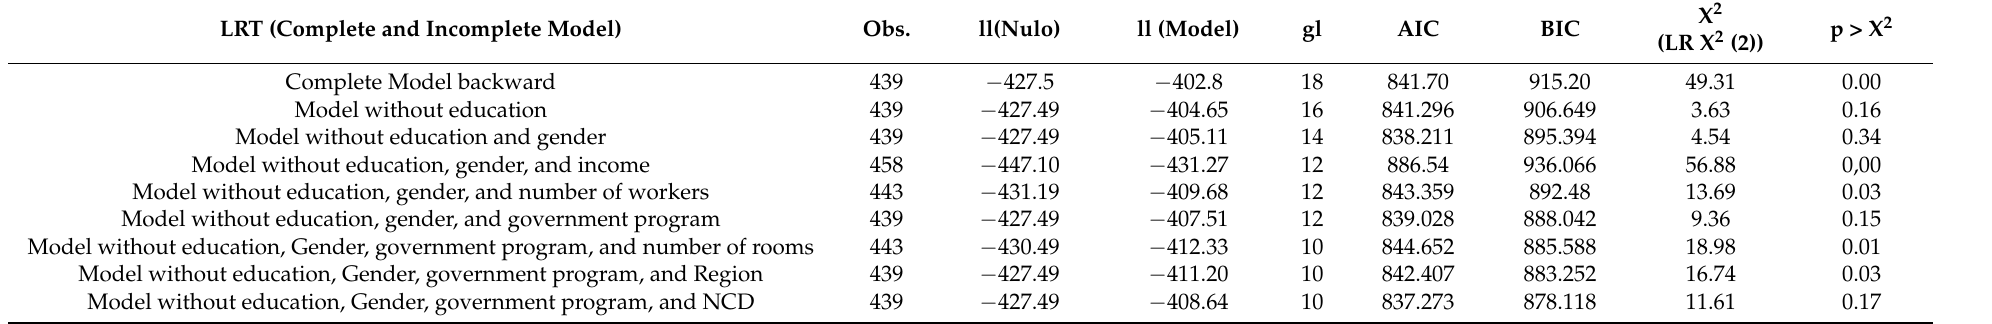
Table 4. Comparison of the complete and incomplete model performed using the Likelihood Ratio Test (LRT)—stepwise backward method.